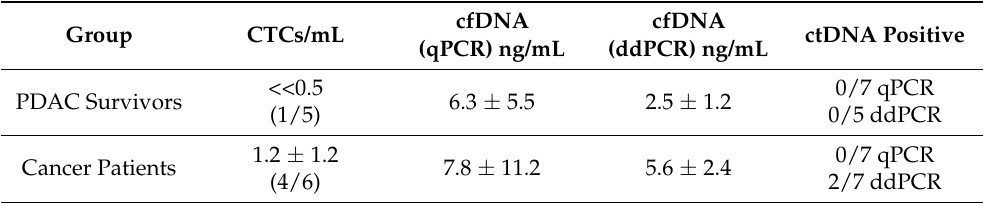
Table 2. CTCs, cfDNA concentration, and ctDNA prior to treatment. Group PDAC Survivors Cancer